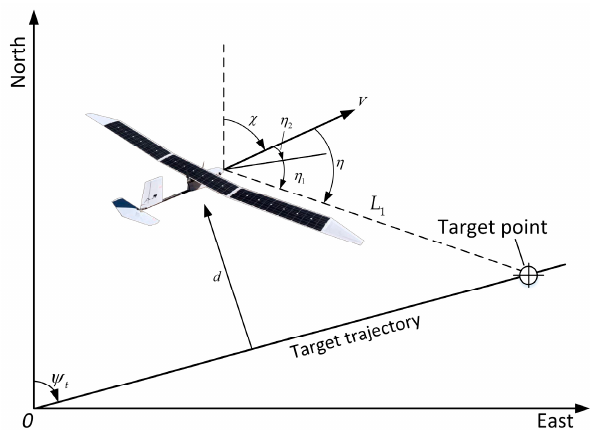
Figure 14. Schematic diagram of UAV and desired flight path.